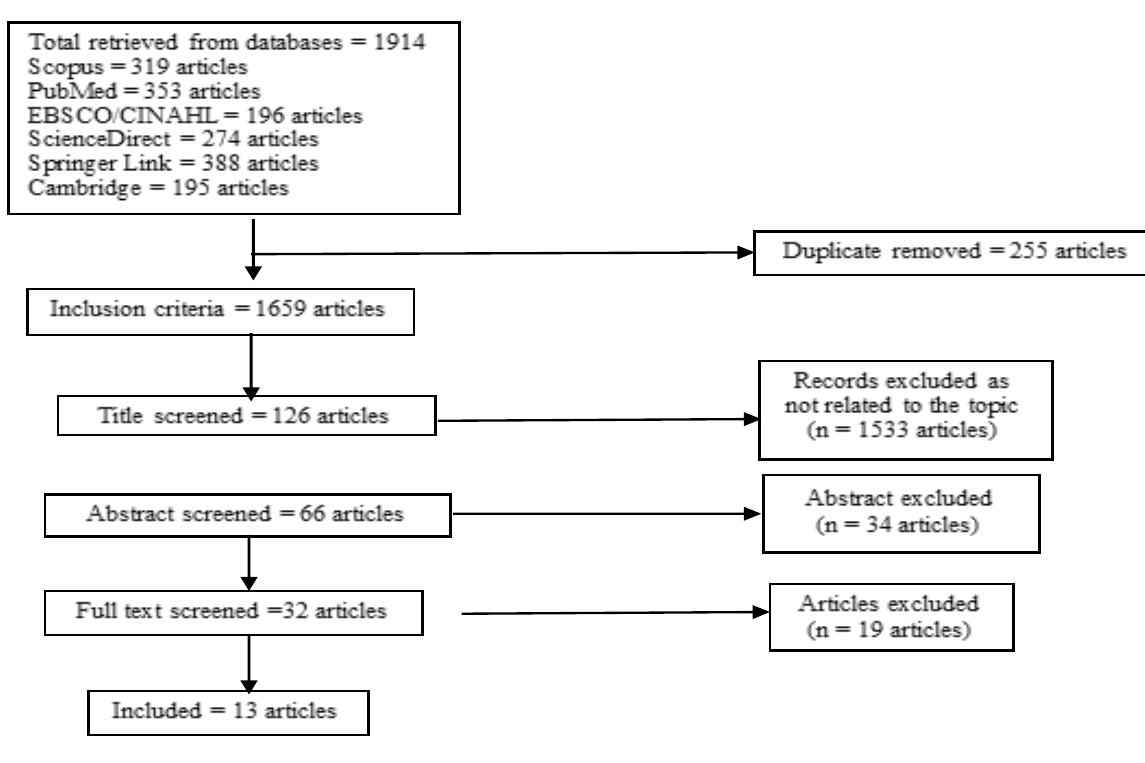
Figure 1. Article selection process